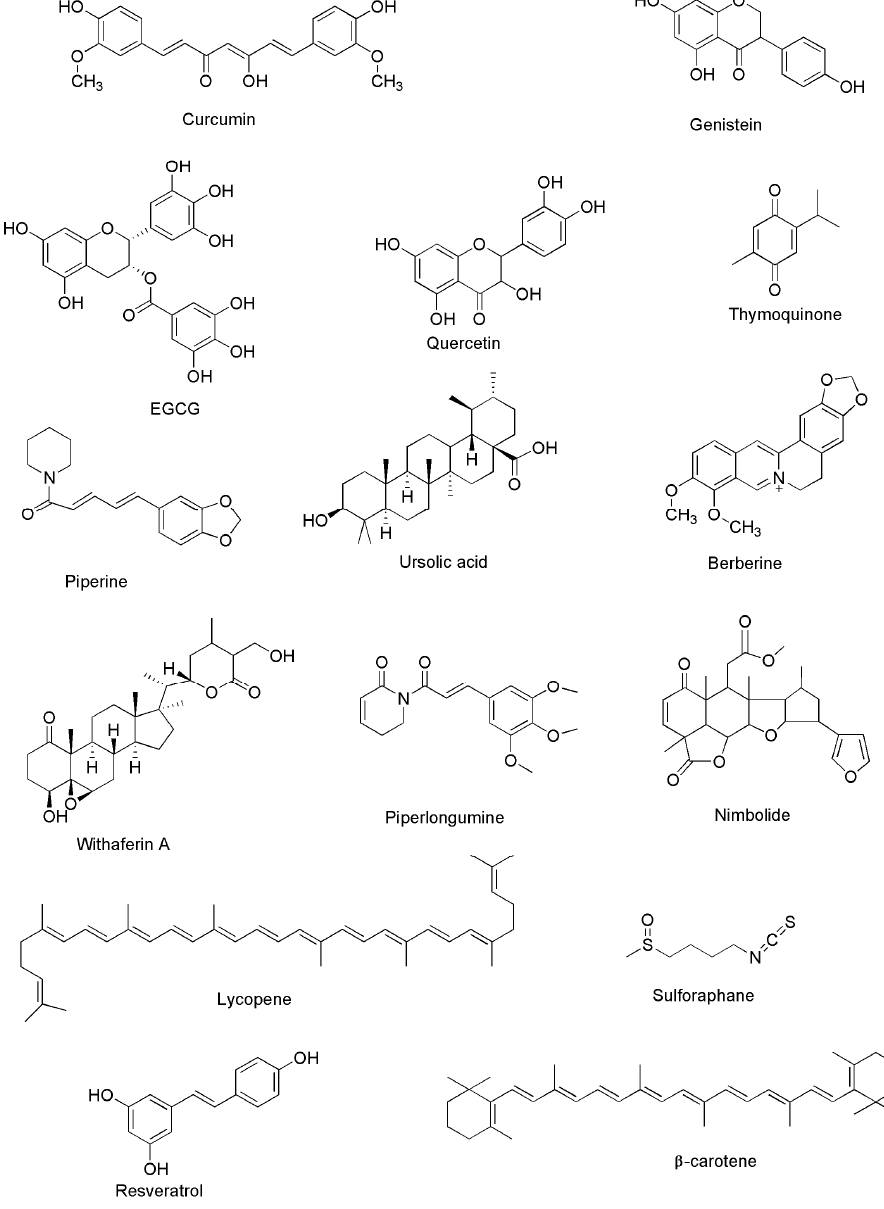
Figure 2. Diagram representing the chemical structure of a few of the well-documented phytochem- icals used for CRC treatment. cals used for CRC